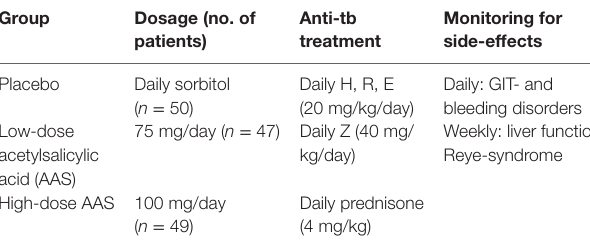
TAbLe 2 | Treatment groups in Schoeman et al.